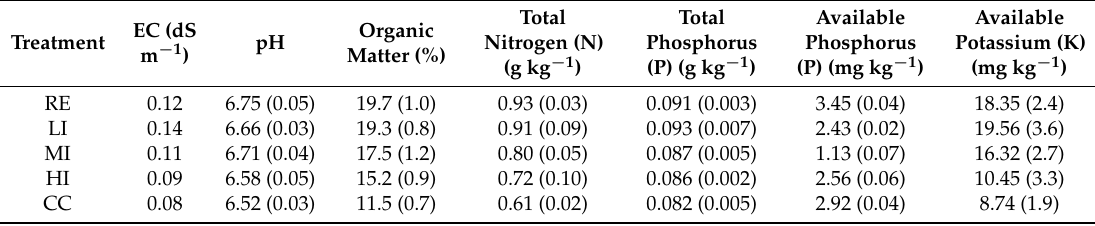
Table 3. Means and standard deviations of soil chemical properties 19 years after